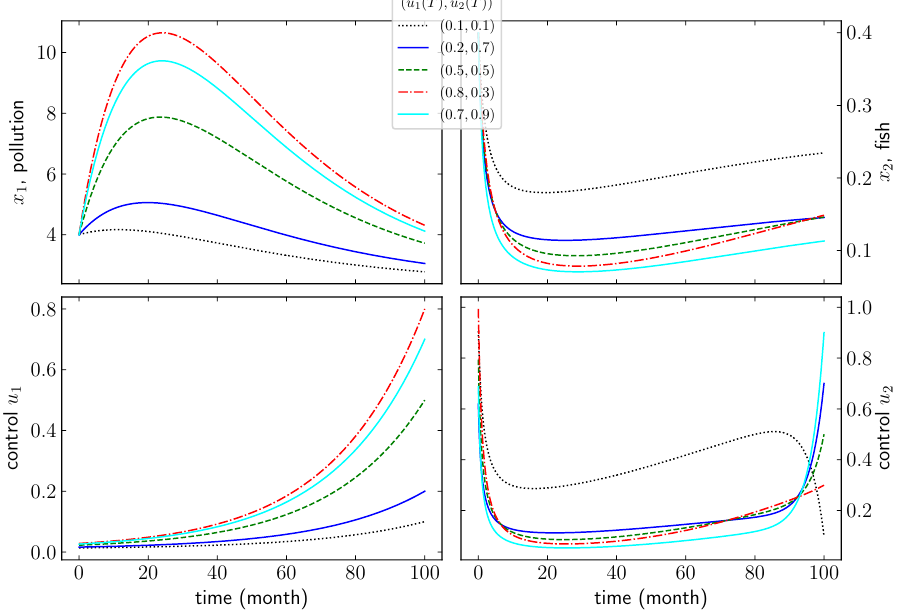
q “ 1 starting at p x 0 ` 1 x 1 1 p T q , u p T qq 2 1